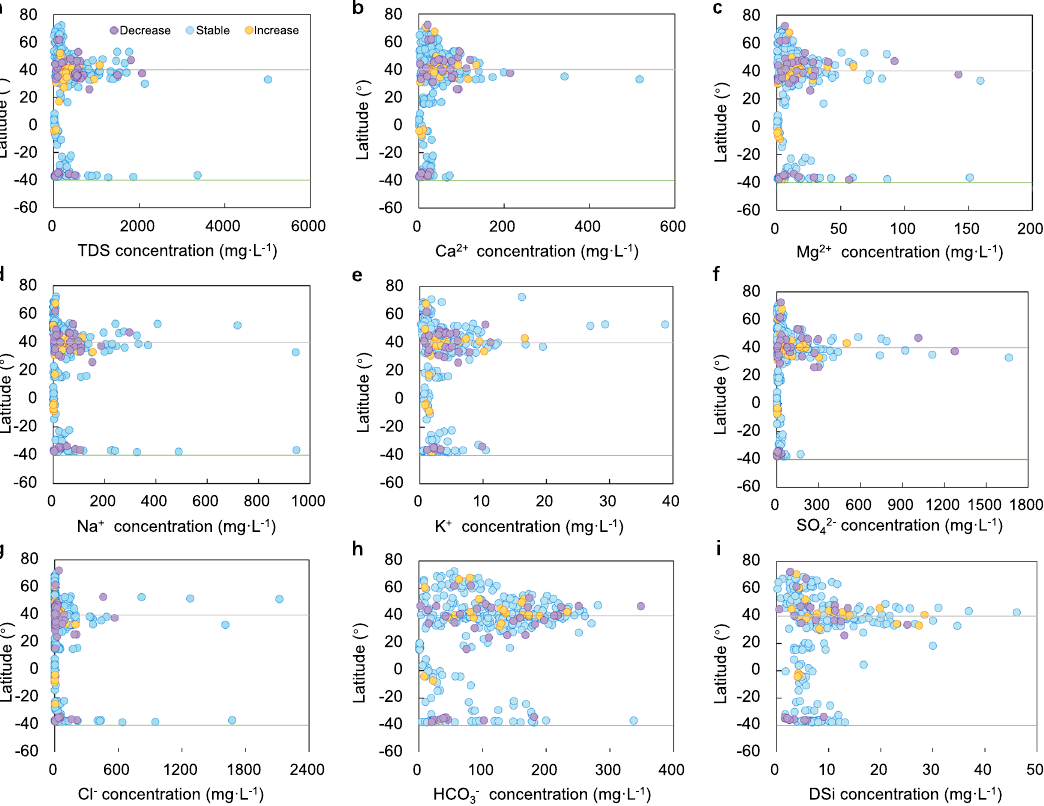
Fig. 4 Latitudinal distribution of mean annual solute concentrations under varying trends in water discharge ( Q ). a Total dissolved solids (TDS). b Ca 2 + . c Mg 2 + . d Na + . e K + . f SO 4 2 − . g Cl − . h HCO 3 − . i Dissolved silica (DSi). The 476dots in purple, blue, and yellow respectively represent rivers with decreasing, stable, and increasing trends in annual